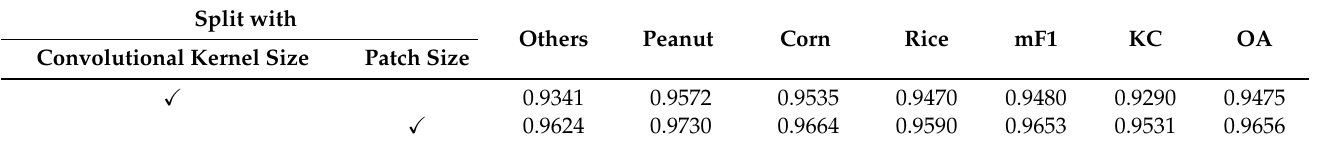
Table 8. Ablation experiments for the network design.